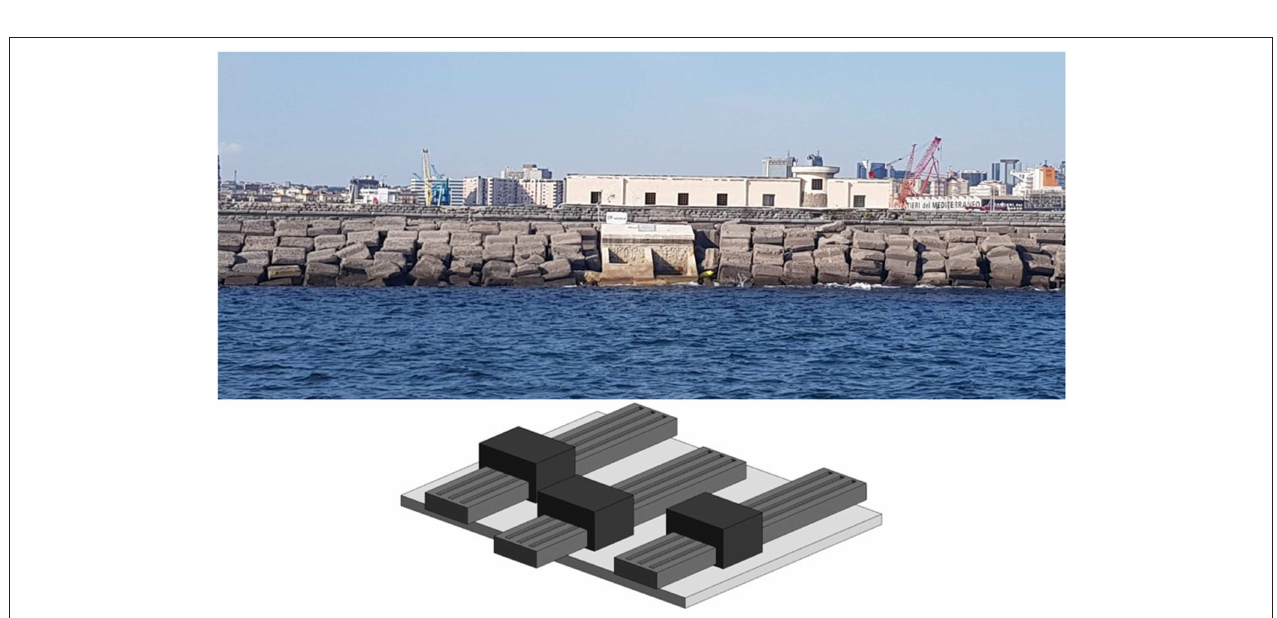
FIGURE 9 | Full scale OBREC in the port of Naples (Top) . Schematic representation of a 40 South Energy H24 wave energy converter plant (Bottom) .